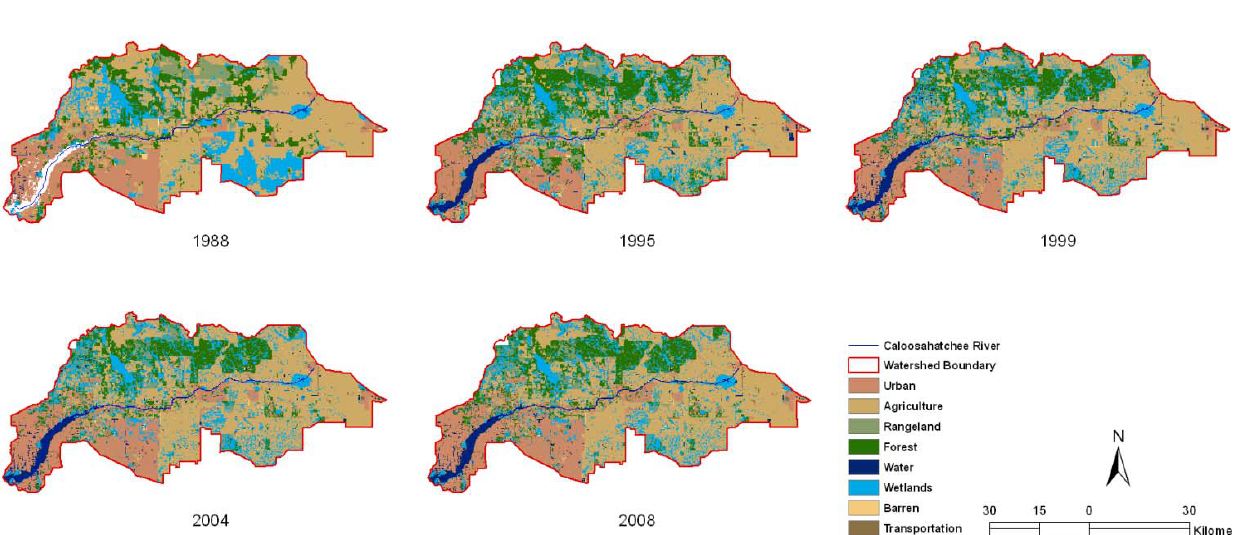
Figure 2. Land-use in the Caloosahatchee River watershed during various periods, as determined from analyses of existing data.